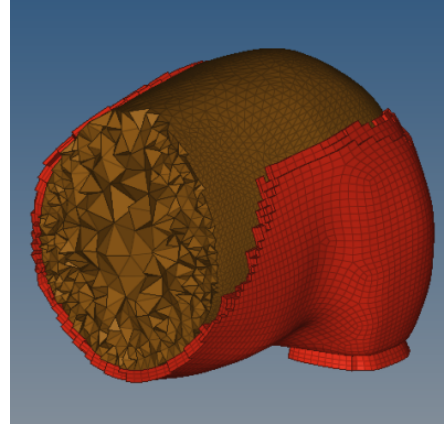
Figure 7. After filling (The brown part is the filling